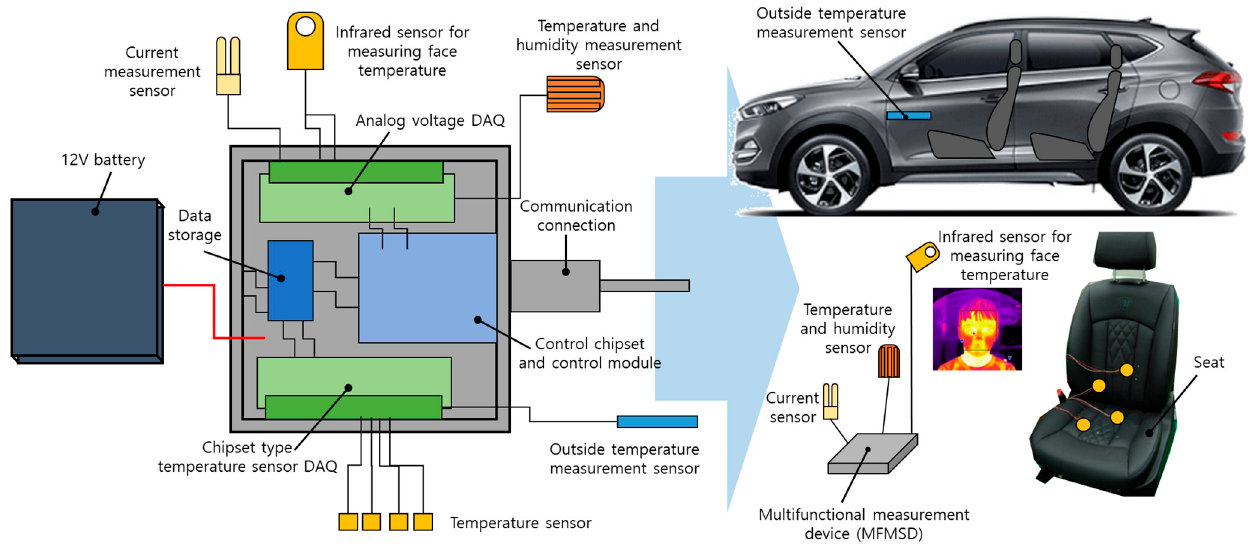
Figure 1. Schematic diagram of equipment setup.